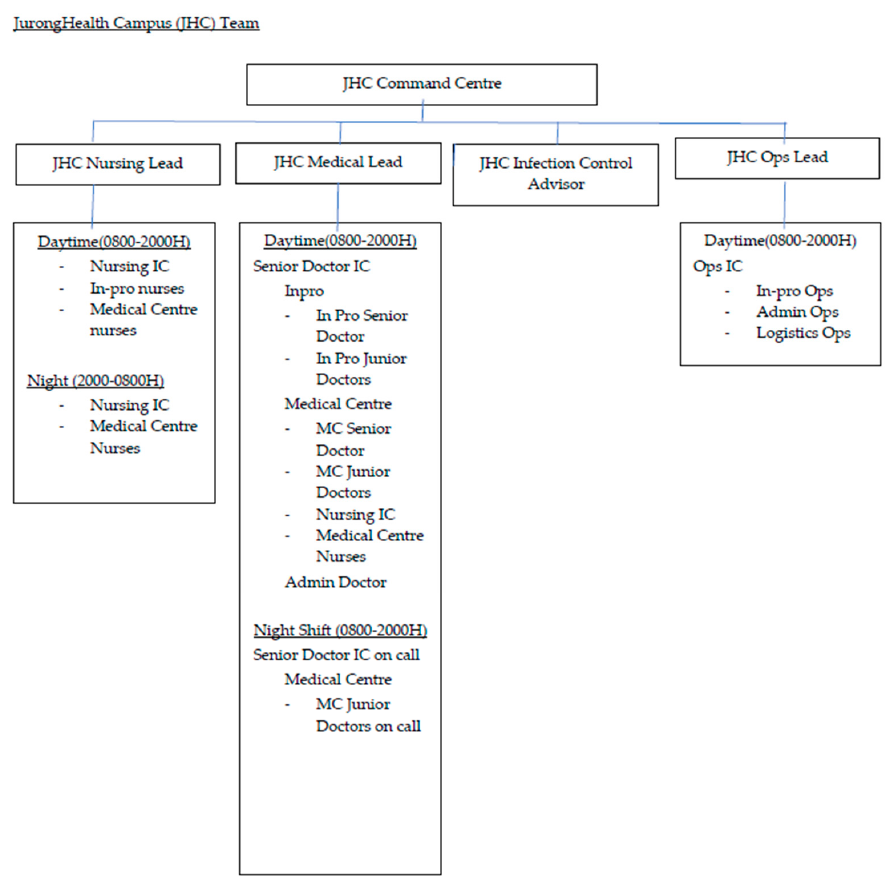
Figure 2. Structure of Jurong Health Campus (JHC) Team.